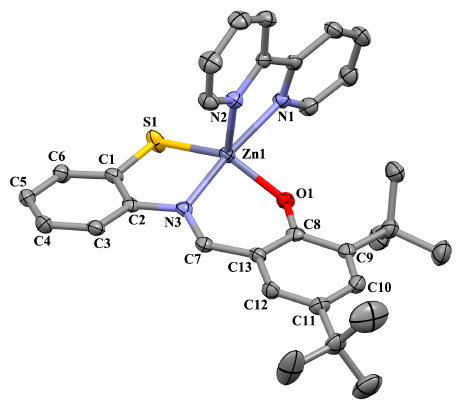
Figure 2. The X-ray structure of 6 . The hydrogen atoms are omitted for clarity. The ellipsoids of 50% probability.